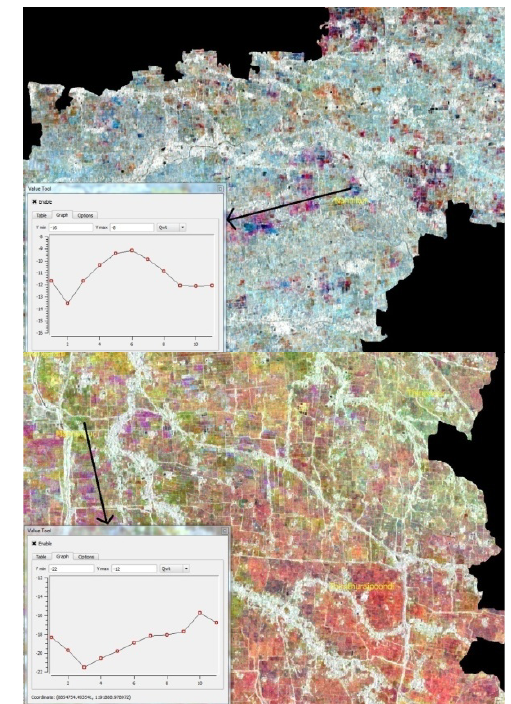
Fig.3. dB stack for VV and VH polarization